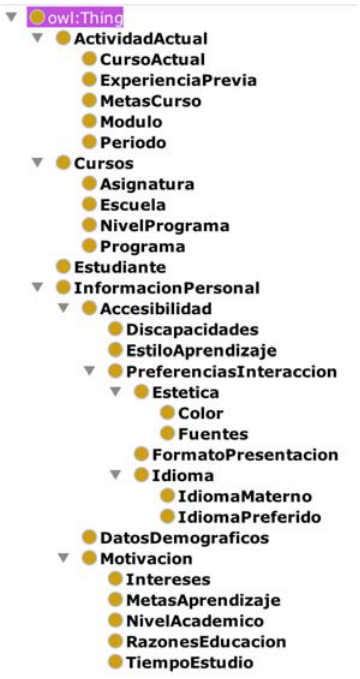
Figure 8. Class hierarchy of OntoOAIStudent ontology.